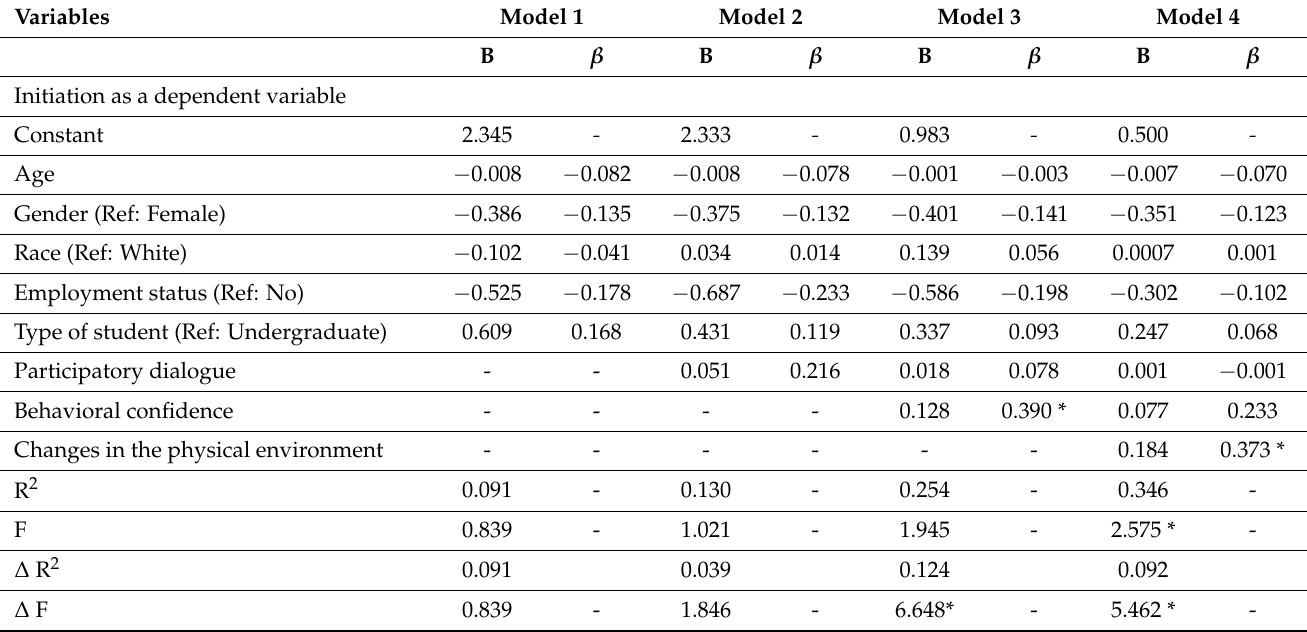
Table 4. Hierarchical regression to predict likelihood for initiation of introspective meditation among participants who were not engaged in the practice ( n = 51).